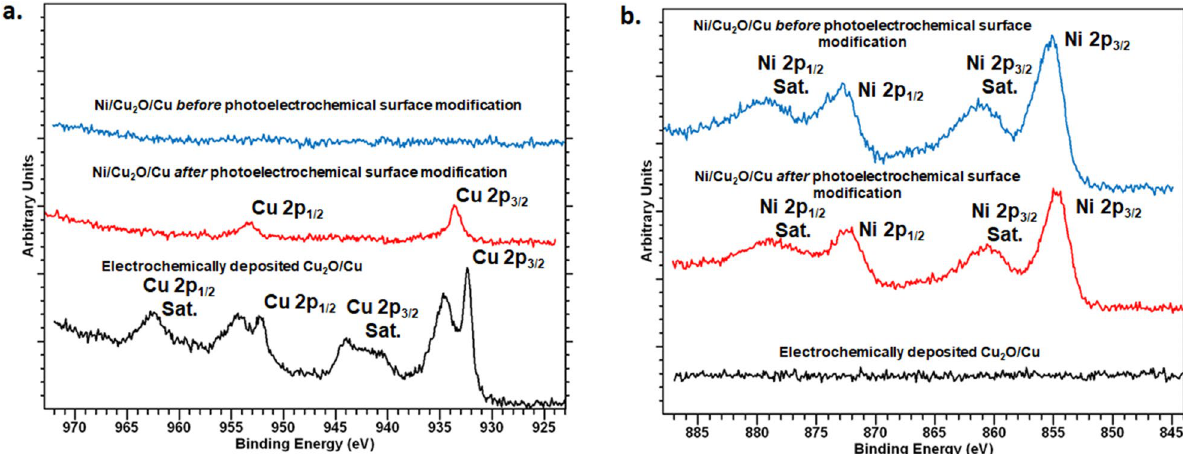
Figure 2. XPS analyses at various stages of the electrode fabrication process. ( a ) XPS spectra of Ni-Cu 2 O-Cu electrode after each step of the fabrication process and after photoelectrochemical surface modification. Main and satellite peaks corresponding to copper and its oxides are annotated. ( b ) XPS spectra of Ni-Cu 2 O-Cu electrode after each step of the fabrication process and after photoelectrochemical surface modification over the range of energies corresponding to nickel; satellite peaks are also marked. The peak between 960 and 965 eV and structure between 940 and 950 eV in the figure on the left is indicative of CuO whereas the other peaks are indicative of Cu 2 O 35 . The split Cu 2p 3/2 and 2p 1/2 peaks in ( a ) indicate the presence of a CuO/Cu 2 O mixed phase. Note that after photoelectrochemical surface modification, only the peaks of Cu (0) are evident (middle curve in red in panel ( a )) and the peaks corresponding to both CuO and Cu 2 O are absent.